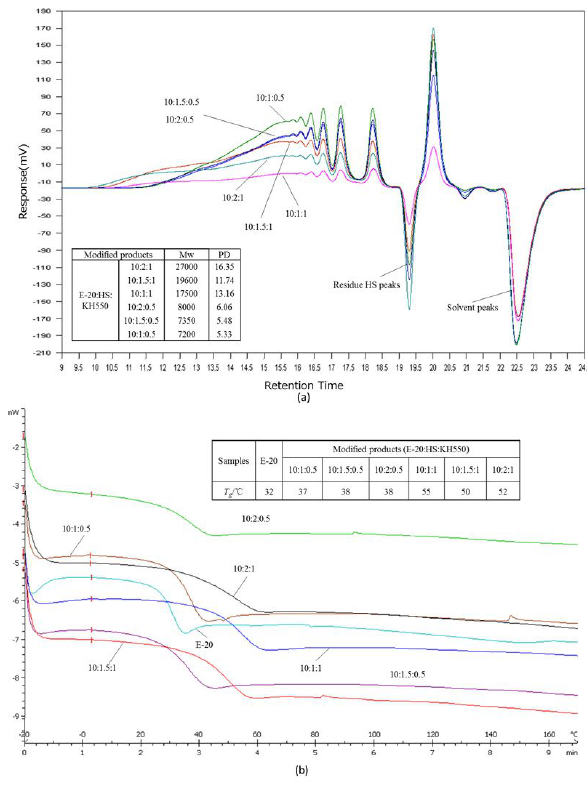
Figure 6: Chemical property characterization of different